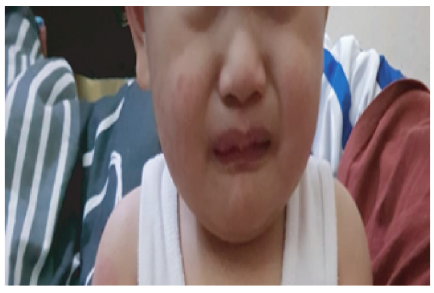
Figure 4: Dry cracked